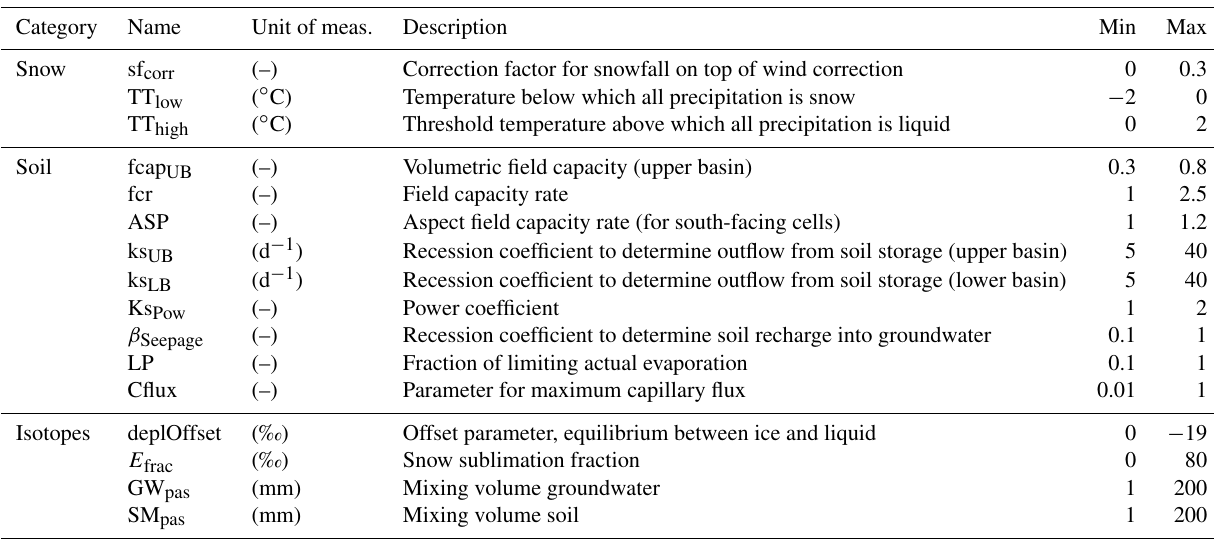
Table 1. Parameters and their range of variation during calibration. Category Name Unit of